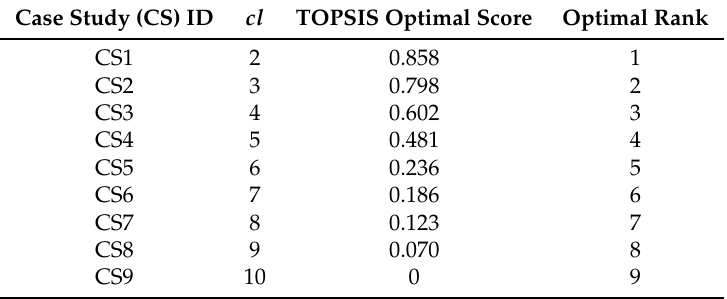
Table 2. TOPSIS optimal scores and optimal ranks for the nine case studies of fuzzy c-means clustering from the scRNA-seq gene expression dataset.